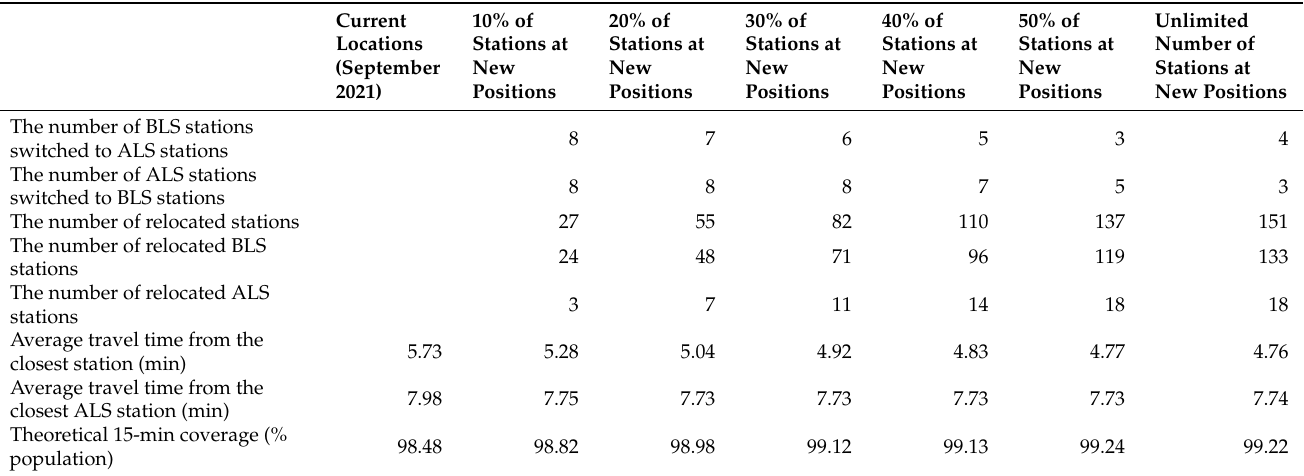
Table 2. Results of the optimization